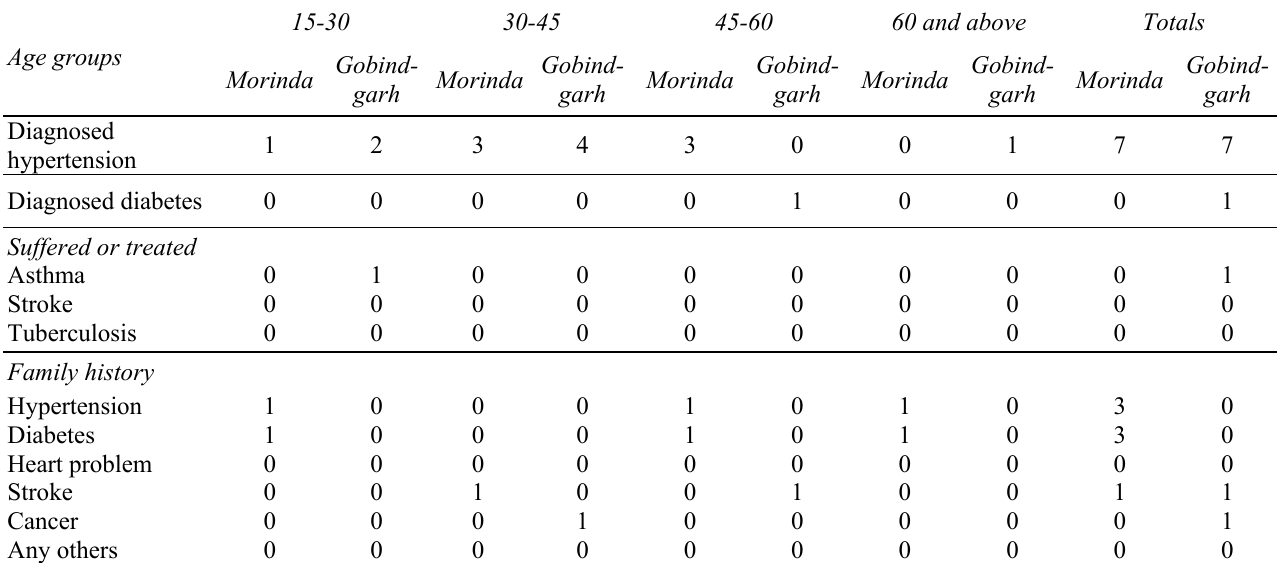
Table 7: Frequency of chest pain and intermittent claudication in the population of different age groups in the two study sites. Age